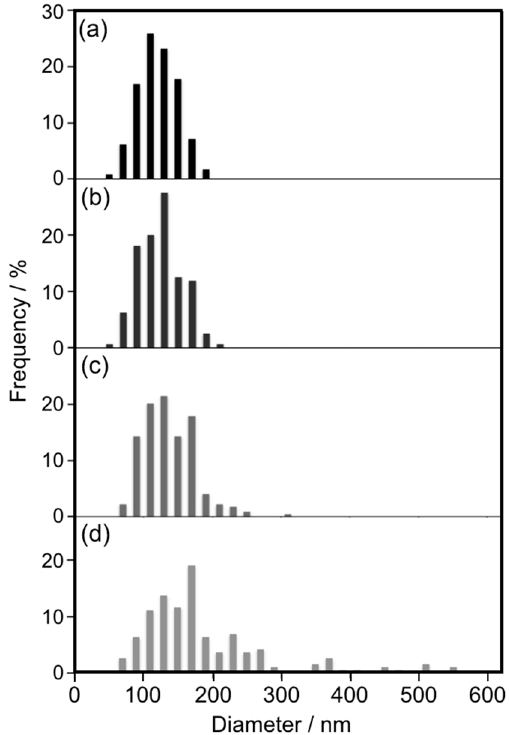
Figure 5. Liposome diameters determined from the cryo-TEM images (Figure S3). DPPC liposomes heated at ( a ) 25 and ( b ) 50 °C for 24 h; ( c ) cAuNP 14 –DPPC and ( d ) cAuNP 31 –DPPC heated at 50 °C for at ( a ) 25 and ( b ) 50 ◦ C for 24 h; ( c ) cAuNP 14 –DPPC and ( d ) cAuNP 31 –DPPC heated at 50 ◦ C for 24 24 h.